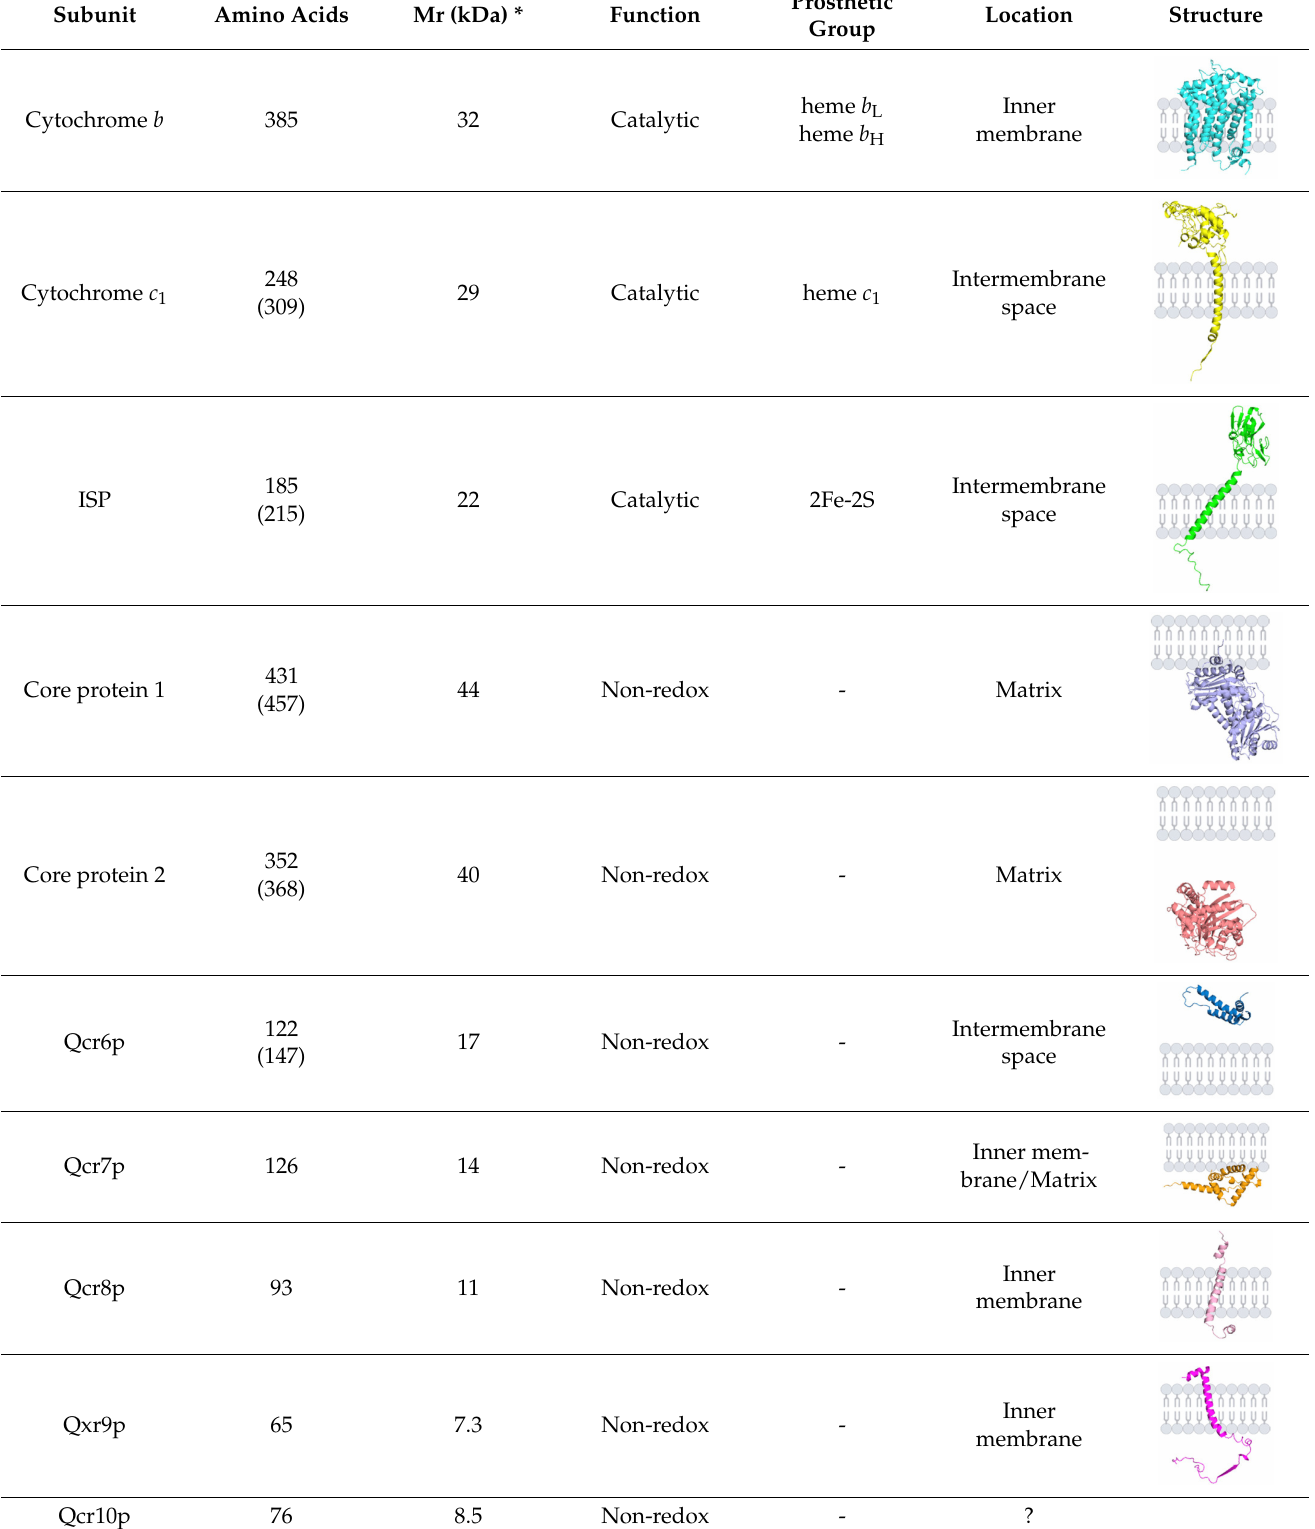
Table 1. Protein subunits of the bc 1 complex in S. cerevisiae